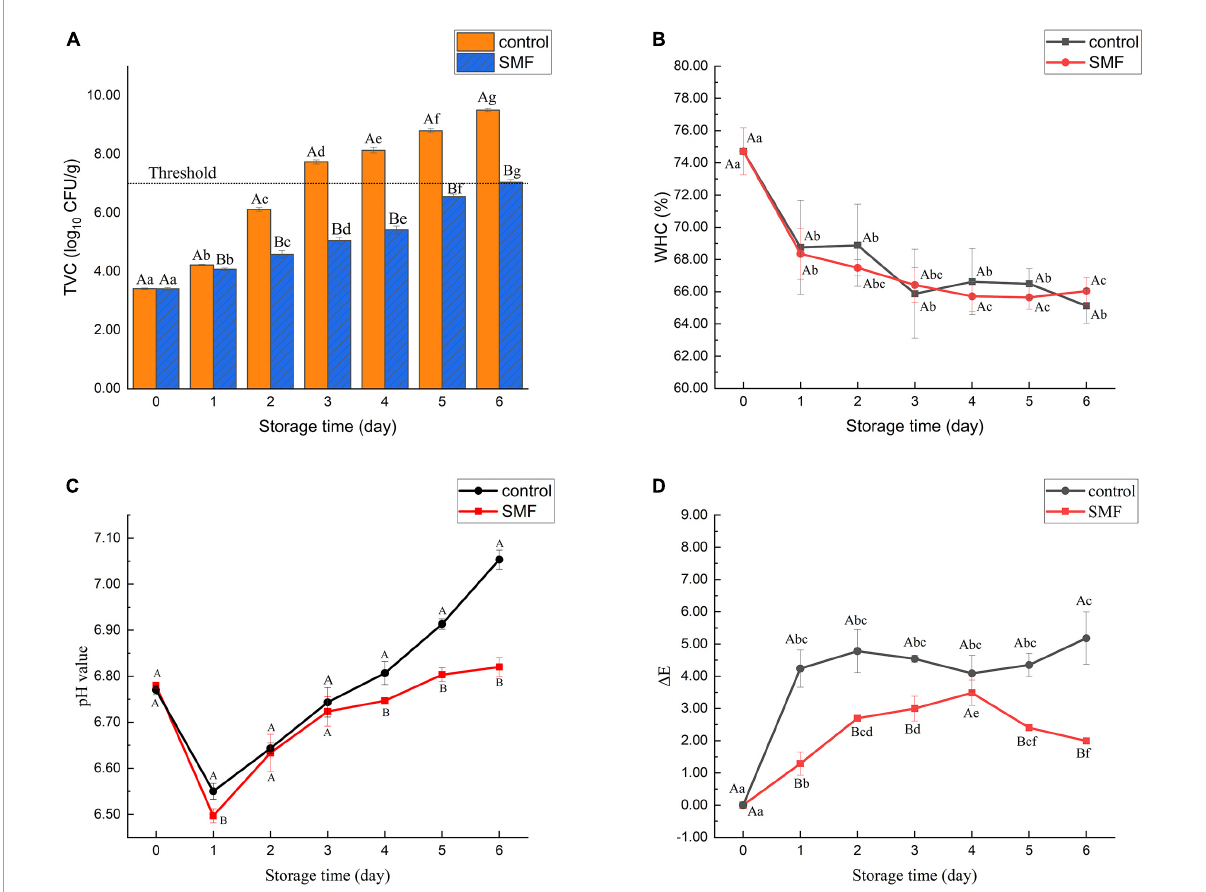
FIGURE1 Changes in TVC (A) , WHC (B) , pH value (C) , and color differences (D) of sea bass fillets with different treatments. The dotted line in panel (A) shows the upper acceptable limit (7.0 log 10 CFU/g). SMF: treated with static magnetic field (5 mT) at 4 ◦ C, control: storage at 4 ◦ C without SMF. Different capital letters indicate statistically significant differences between samples with different treatments on the same day ( p < 0.05), and different lowercase letters indicate statistically significant differences between samples with different storage time under the same treatment ( p < 0.05), the same